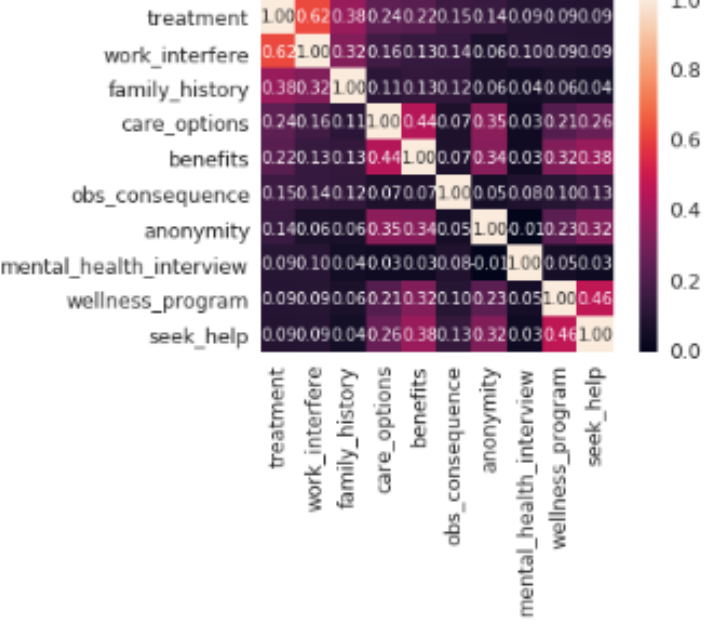
Figure 11: Treatment correlation matrix